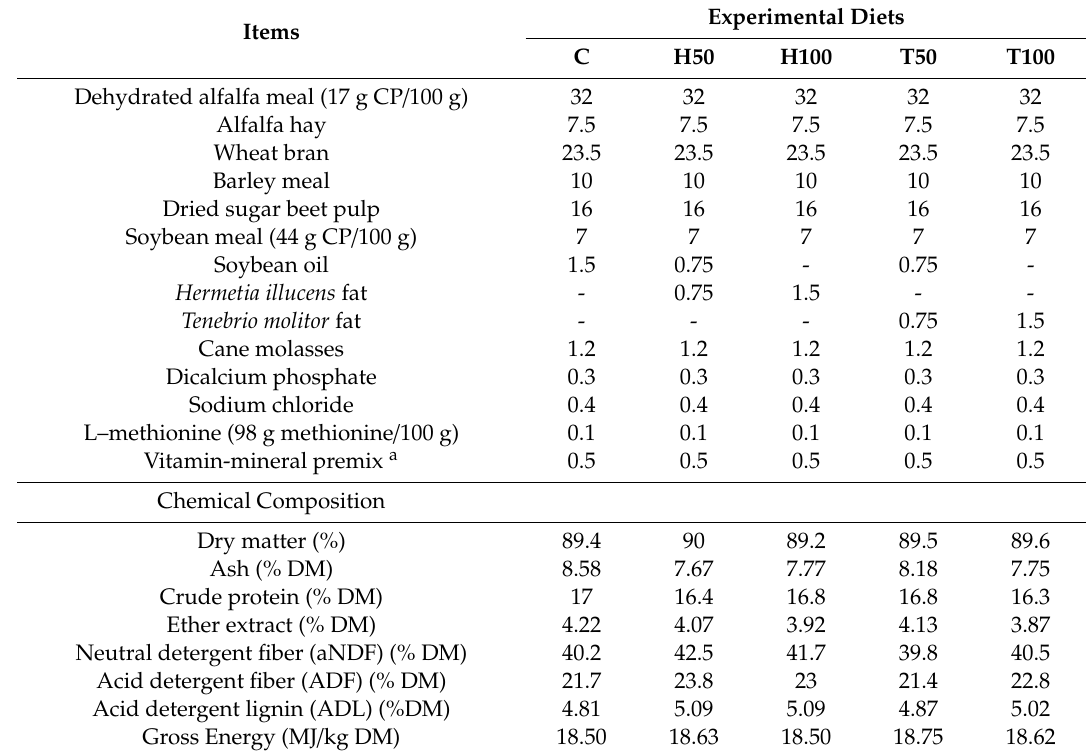
Experimental Diets